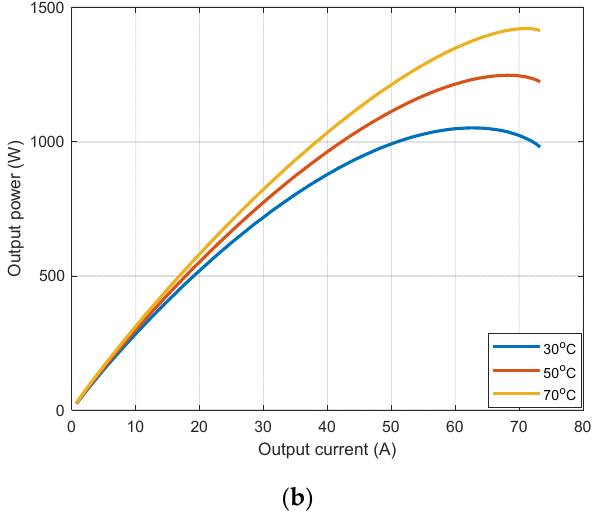
Figure 7. Characteristics of Ballard stack under various temperatures: ( a ) current-voltage and ( b ) current-power.